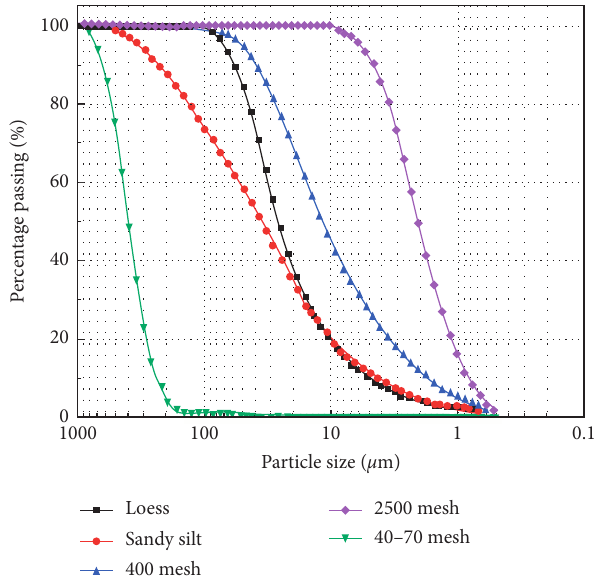
Figure 3: Grain size accumulation